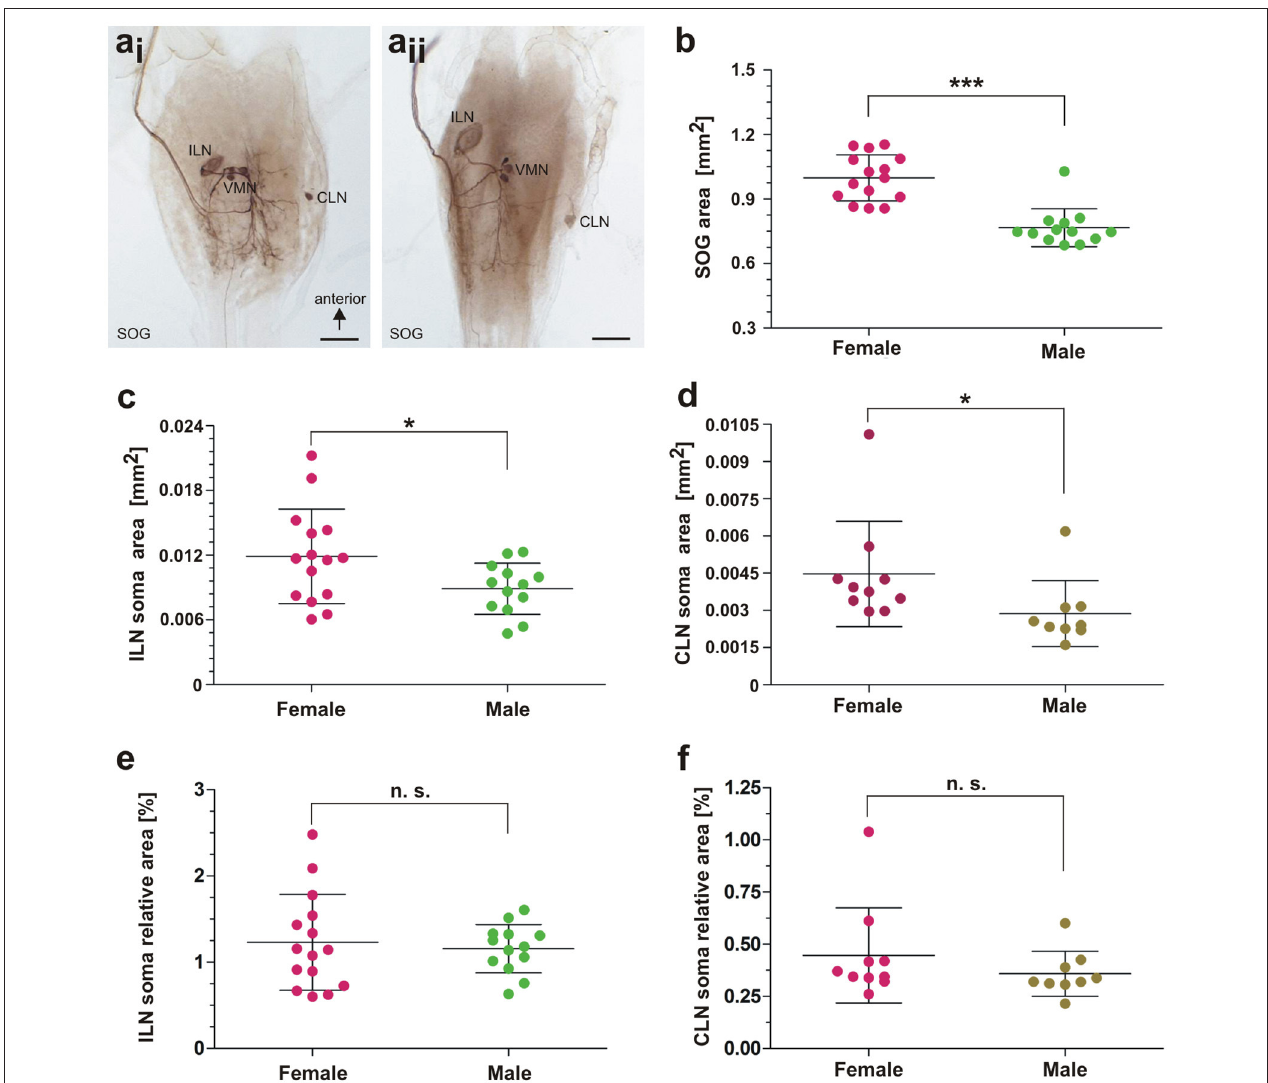
FIGURE 9 | Morphometrical analysis of neuronal elements. (a) Examples of ILN size differences between two male individuals. (b) Comparison of subesophageal ganglion area in females and males; Mann-Whitney test, p < 0.0001. (c) Comparison of ILN soma area in females and males; Mann-Whitney test, p < 0.05. (d) Comparison of CLN soma area in females and males; Mann-Whitney test, p < 0.05. (e) Comparison in ILN soma relative area in females and males; Mann-Whitney test, p > 0.05. (f) Comparison in CLN soma relative area in females and males; Mann-Whitney test, p > 0.05. Scales = 500 µ m. For details, see